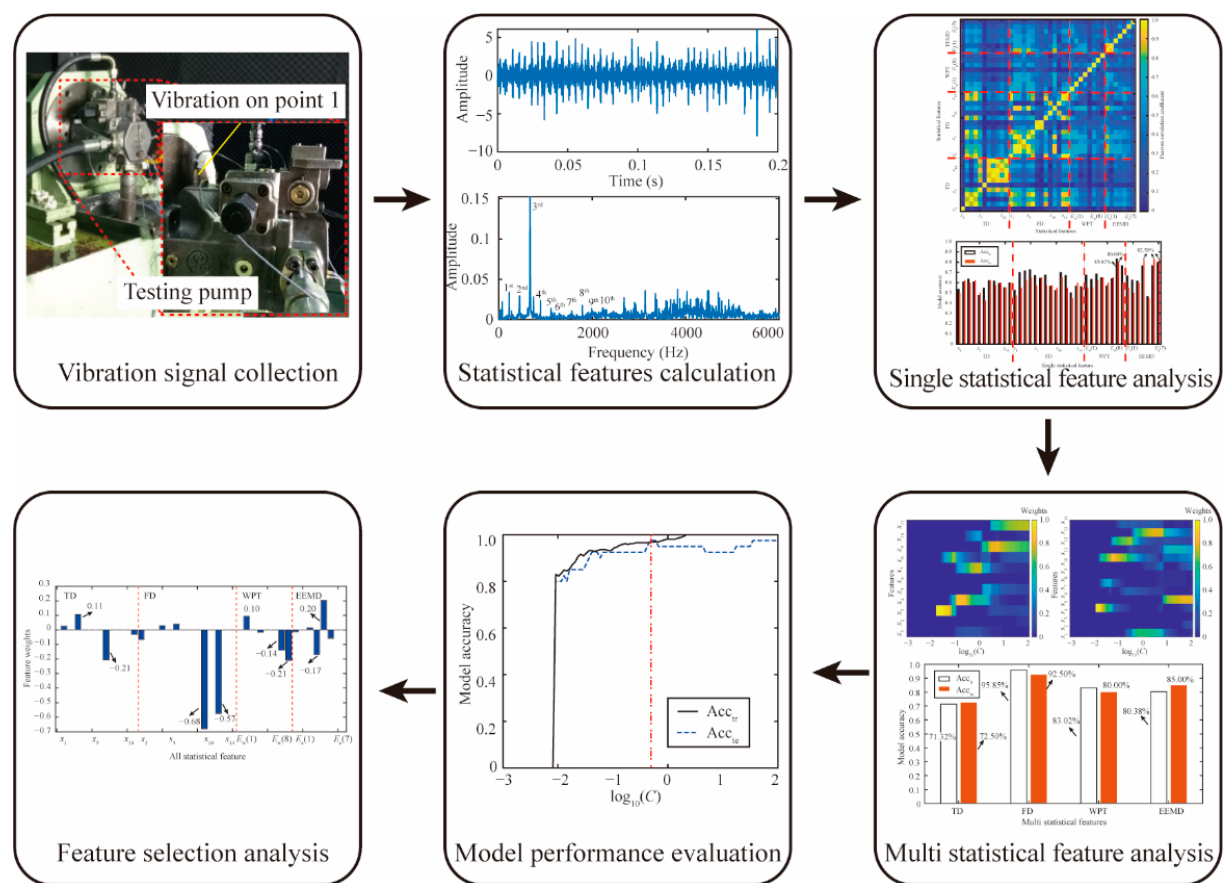
Figure 7. Flowchart of the improved SPARE-SVM-based methodology.